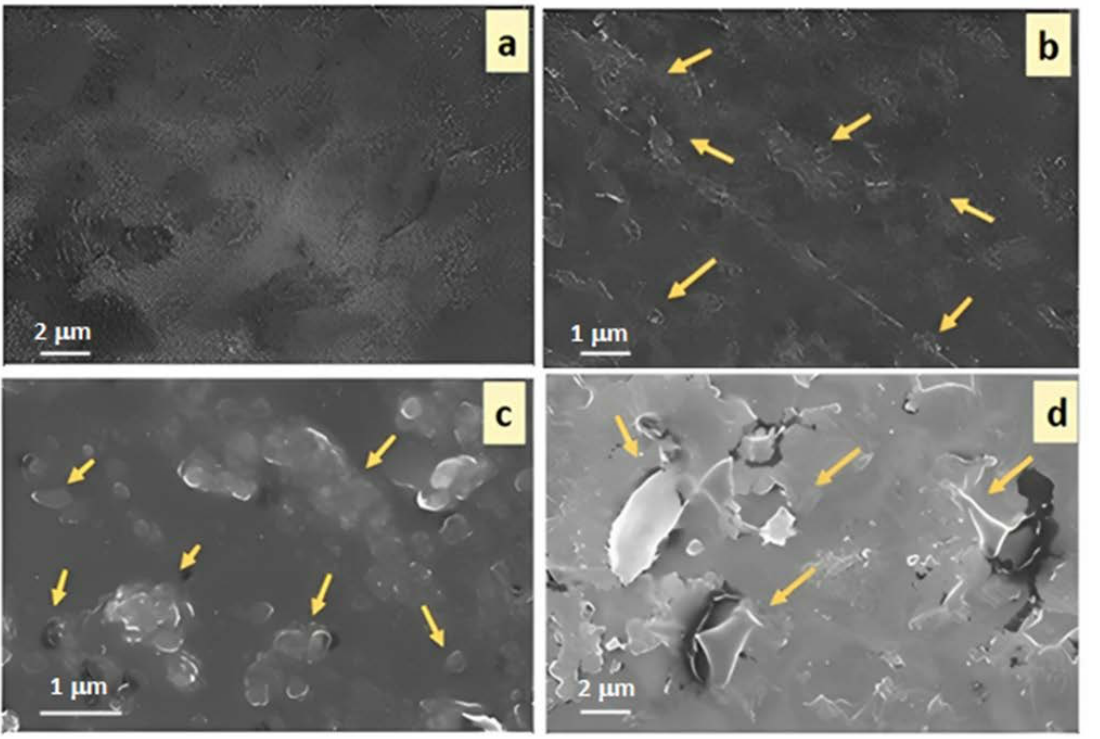
Figure 6. SEM micrographs in ( a ) Pristine PS (SN0), and PS/m-BN composites, as ( b ) SN10 in, ( c ) SN20 in and ( d ) SN30